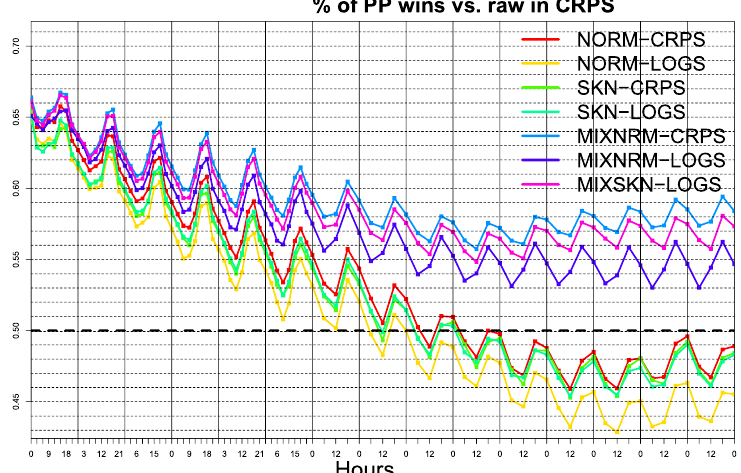
Figure 7. Proportion of the cases where the CRPS of the postprocessed forecasts are better than the RAW forecast. This tool demonstrates that the MIXNRM-CRPS wins 1% more than the other methods against the RAW ensemble for the longest lead